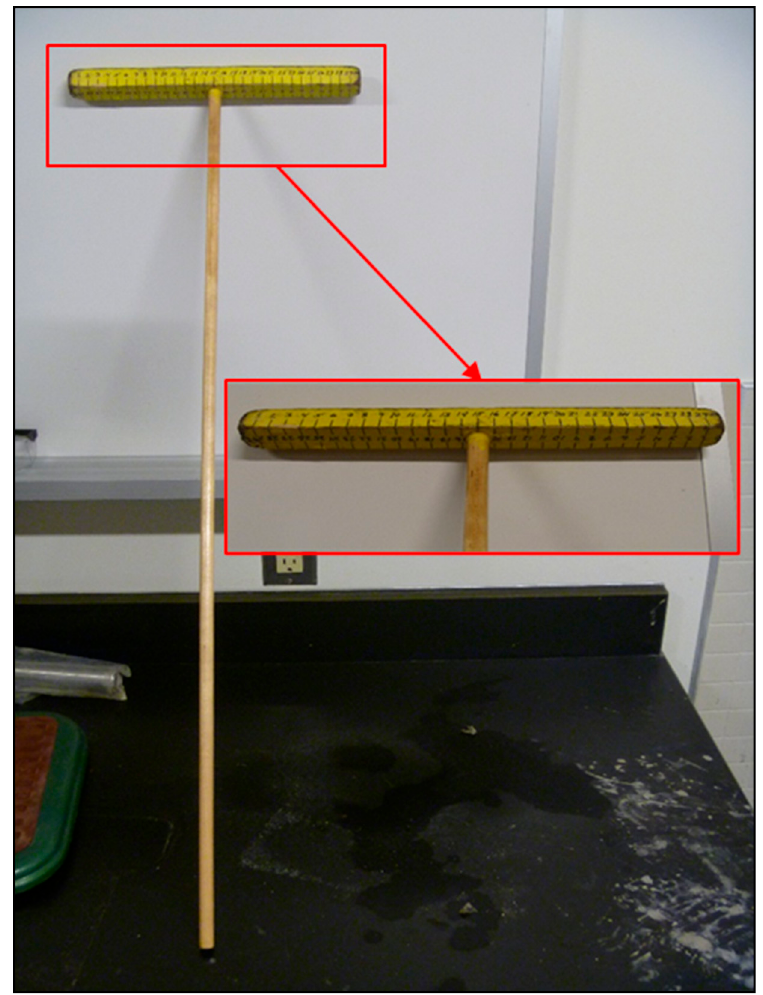
Figure 3. Metric T-scale used as a linear scale when imaging vehicle.